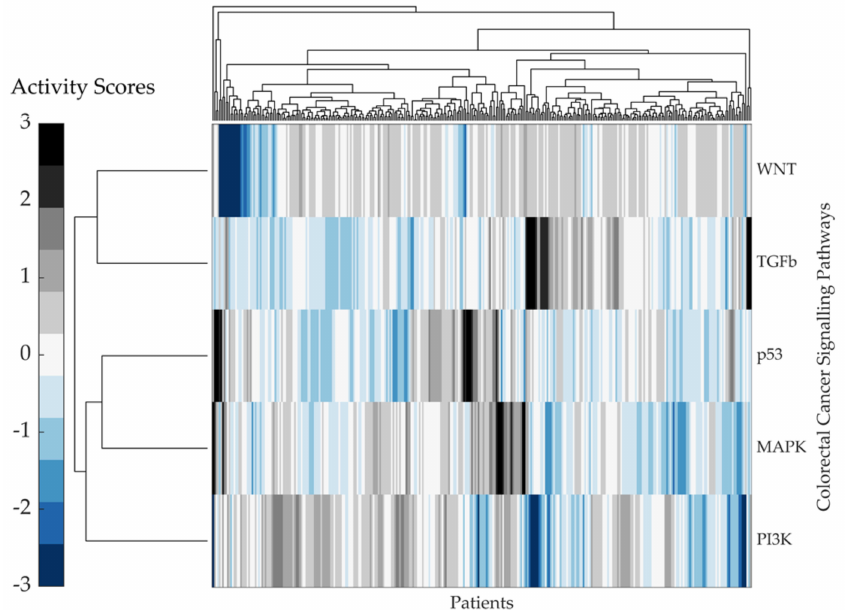
Figure 6. PROGENy pathway activity scores from the RNA Sequencing expression dataset. Heatmap visualising the z -coefficients matrix for all features in each CRC signalling pathway for all 329 patients within the RNA sequencing TCGA legacy dataset cohort. The colourmap on the left indicates the activity score values ranging from 3– − 3. The Euclidean distance metric was used to pass the pairwise distance between observations between both rows and columns. The complete linkage method was used to create the hierarchical cluster tree. Data were clustered along the columns of data, then along the rows of row-clustered